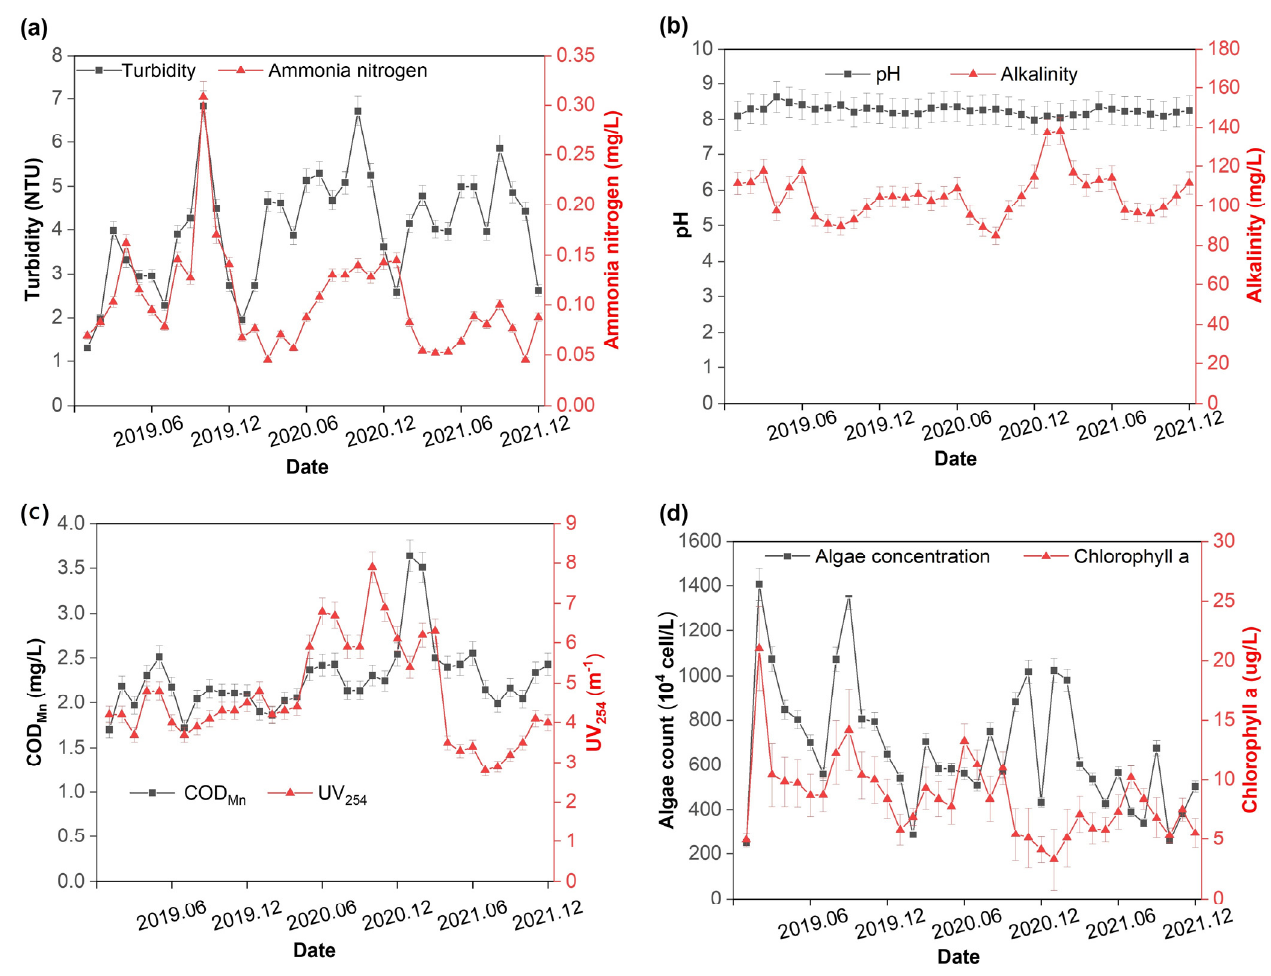
Figure 2. ( a ) Turbidity and ammonia nitrogen content of the raw water from 2019 to 2021; ( b ) pH and alkalinity of the raw water from 2019 to 2021; ( c ) COD Mn and UV 254 of the raw water from 2019 to 2021; and ( d ) algal cell concentration and chlorophyll a of the raw water from 2019 to 2021.